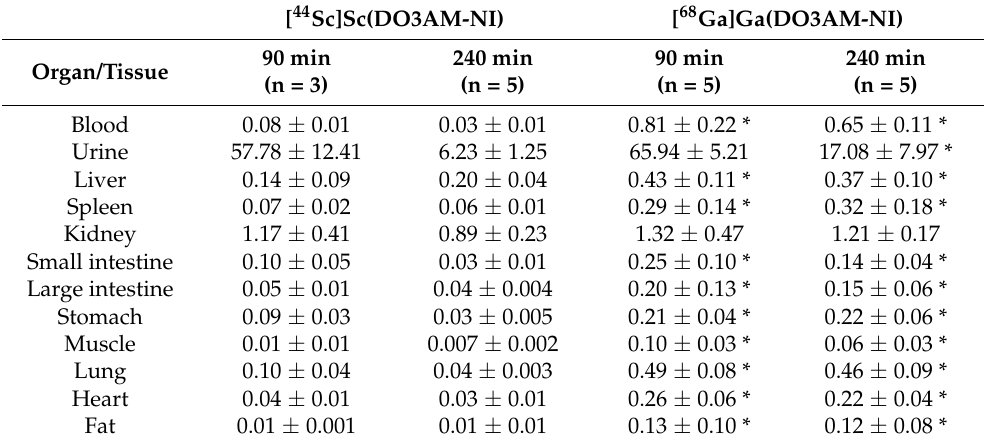
Table 2. Ex vivo biodistribution of [ 44 Sc]Sc(DO3AM-NI) and [ 68 Ga]Ga(DO3AM-NI) (%ID/g) in healthy control SCID mice 90 and 240 min after tracer injection. Significance level between [ 44 Sc]Sc(DO3AM-NI) and [ 68 Ga]Ga(DO3AM-NI) at 90 and 240 min: p ≤ 0.01 (*). %ID/g values are presented as mean ±